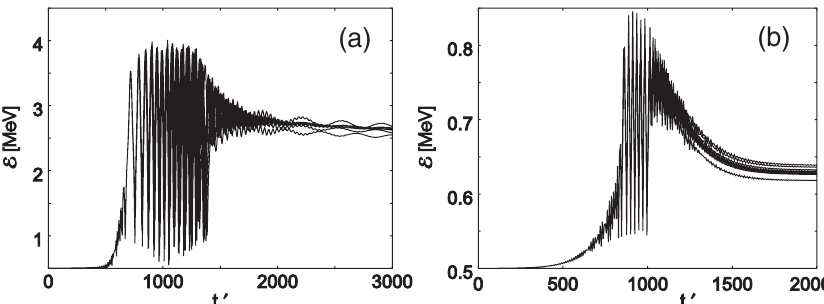
FIG. 4. The dependence of the particle energy on the initial transversal positions ( y 0 ) in the reflection-capture regime by two nonplane counterpropagating laser pulses: (a) y 0 2 ½ 0; 3 (cid:5) 1 (cid:2) (with the step 0 : 5 (cid:5) 1 ) for ! 1 =! 2 ¼ 10 , and (b) y 0 2 ½ 0; 4 (cid:5) 1 (cid:2) (step 0 : 5 (cid:5) 1 ) for ! 1 =! 2 ¼ 2 . Here longitudinal coordinate x 0 ¼ 0 , other parameters are the same as for Fig.